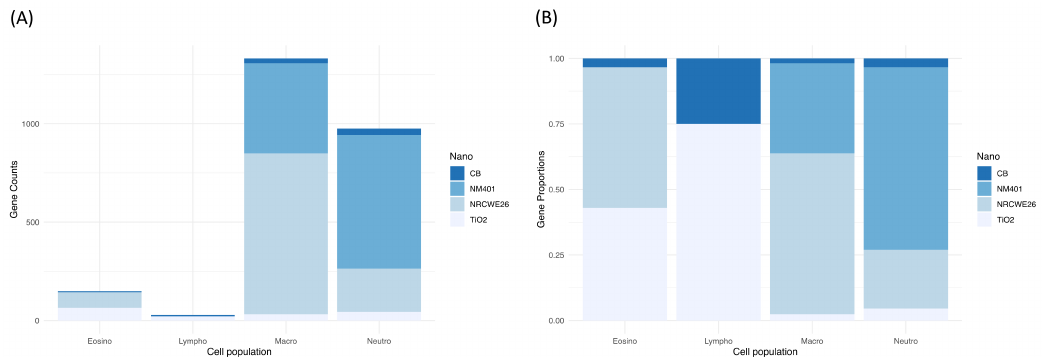
Figure 3. ( A ) Number of dynamic dose-dependent genes correlated with cell counts for each ENM. ( B ) Proportion of dynamic dose-dependent genes correlated with cell counts for each